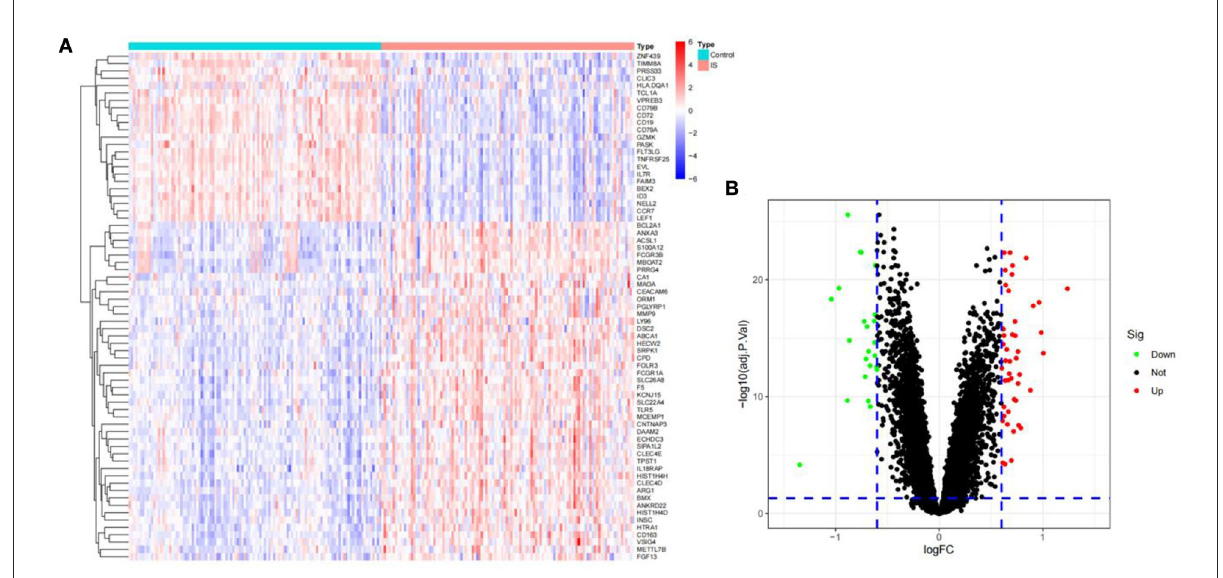
FIGURE2 The DEGs between ischemic stroke and control group in the GSE16561, GSE58294, and GSE37587 datasets. (A) Heatmap of DEGs. The red and blue represent the significantly upregulated and downregulated DEGs. (B) Volcano plot of DEGs. These genes consist of 46 upregulated genes and 23 downregulated genes. The screening criteria were set as |log 2 FC| > 0.6 and adjusted P - value of < 0.05.